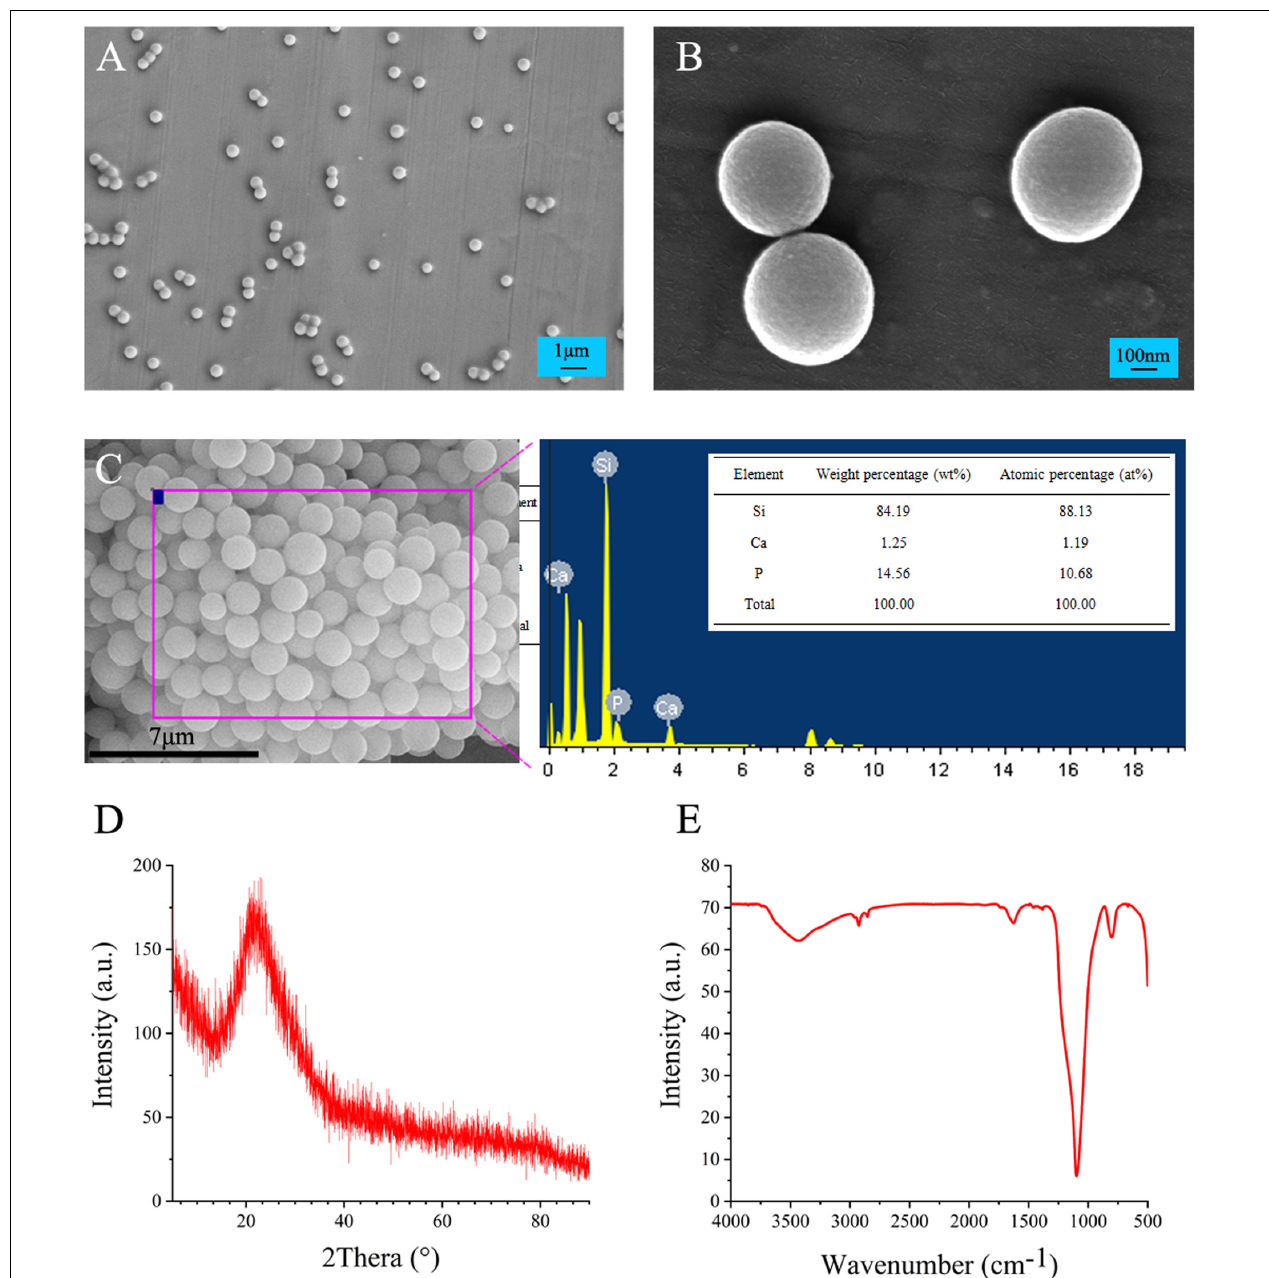
FIGURE 1 | Physicochemical characterization of mesoporous BG nanoparticles. (A,B) SEM micrographs, (C) EDX elemental composition analysis, (D) XRD patterns, and (E) functional analysis by FTIR.